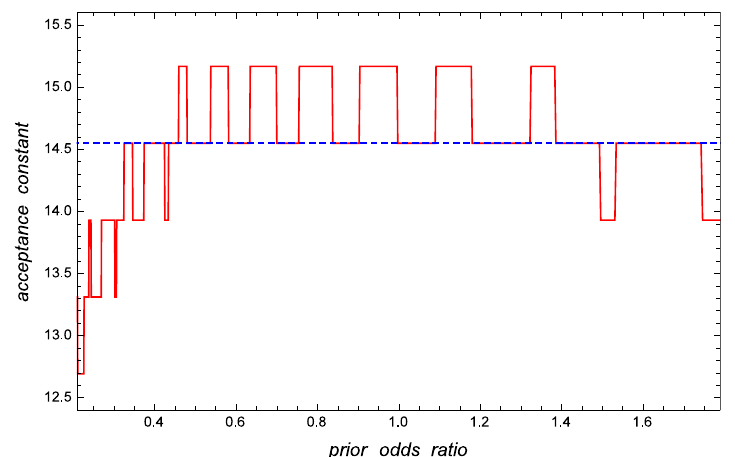
Figure 4. Optimal Bayesian ( solid line ) and frequentist ( dashed line ) acceptance constants, c ∗ and c f , versus the prior odds ratio when µ 0 = 0.35, µ 1 = 0.65, d 0 = d 1 = 1, α = 0.05 and β =